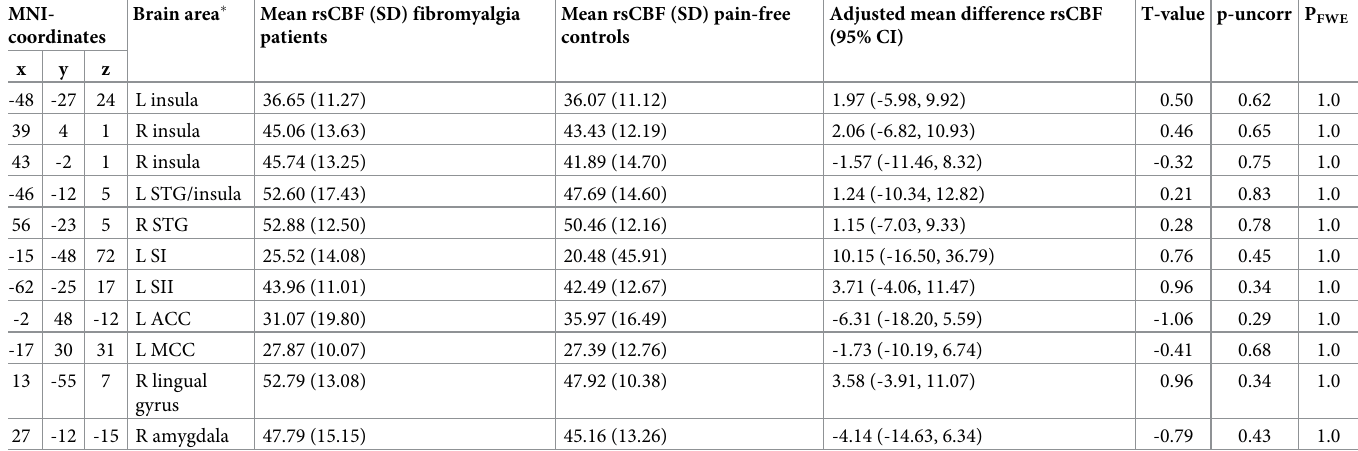
Table 2. Adjusted differences in resting state perfusion (rsCBF, ml/100g/min) between 32 fibromyalgia patients and 32 pain-free controls in 11 pre-specified Regions of Interest. MNI- Brain area coordinates